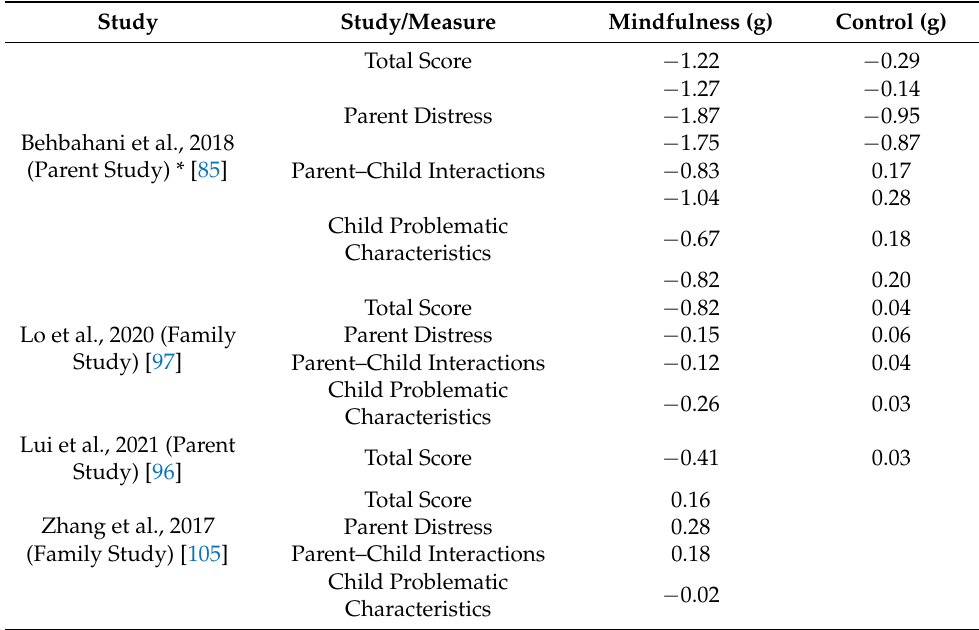
Table 7. Parent Stress Index effect sizes for studies using the 36-item